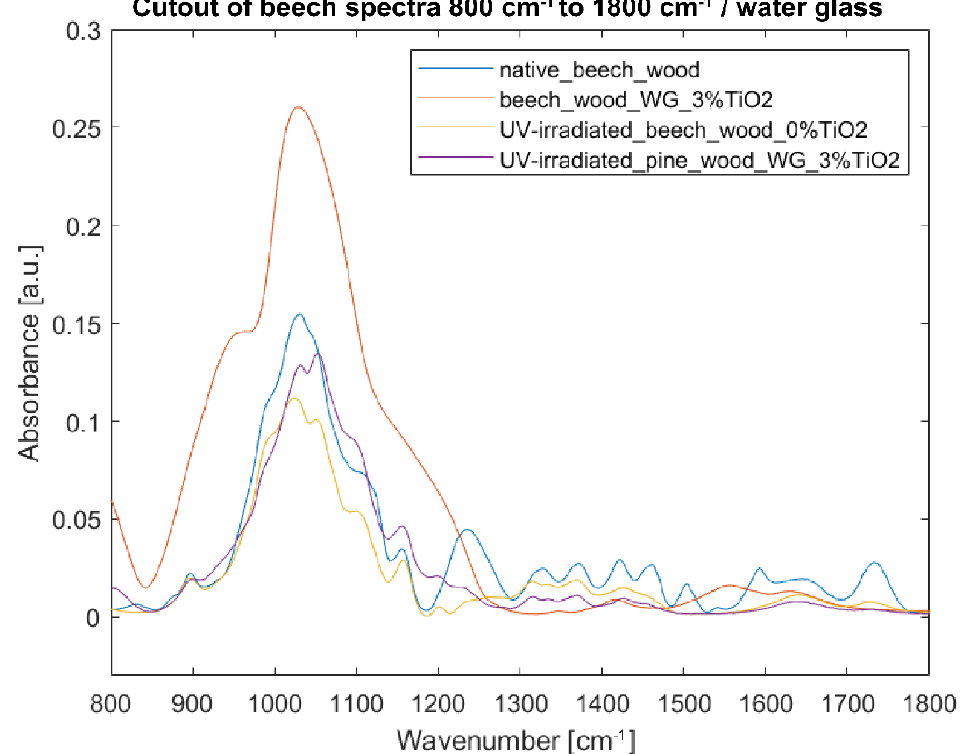
Figure 13. FTIR-ATR spectra of beech wood samples in the fingerprint region 800 – 1800 cm − 1 : (blue) reference sample of native beech wood, (red) beech wood with 3% TiO 2 water glass coating, (yellow) UV-irradiated beech wood without TiO 2 coating, and (purple) UV-irradiated beech wood with 3% TiO 2 water glass coating.